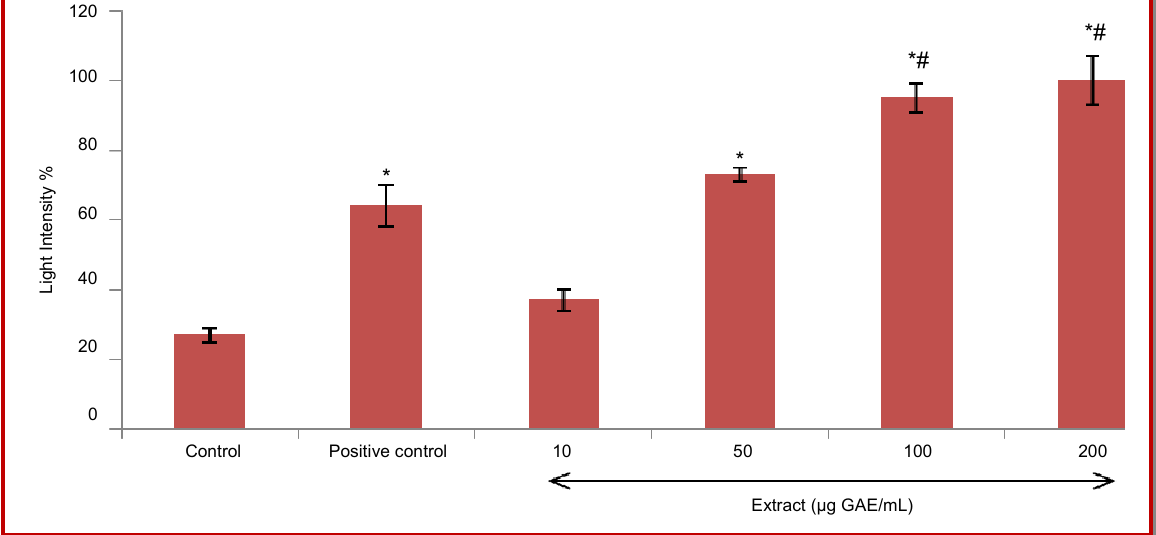
Figure 1: Effect of extract of different GAE concentrations on amount of reactive oxygen species in terms of intensity of fluores- cence by DCF taking maximum (extract 200 µg GAE/mL) as 100%. Results represent the mean DCF fluorescence with error bars representing SD from three experiments. Positive control represented the treatment of the cells with 100 µM H 2 O 2 . *represents significant difference at p<0.05 from the untreated control and #represents the significance in comparison to standard (H 2 O 2 100 µM) positive control